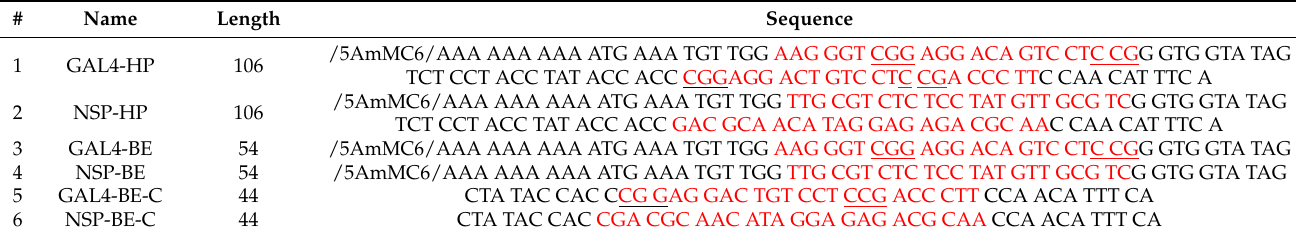
Table 1. DNA oligomers used in the study. Sequences 1-4 were grafted on the Reflective Phantom Interface (RPI)-sensing surface. Sequences 5 and 6 were used to hybridize sequences 3 and 4, respectively. The red part represents the region that differs between specific and nonspecific strands. CGG and CCG sequences, important for GAl4 binding, are